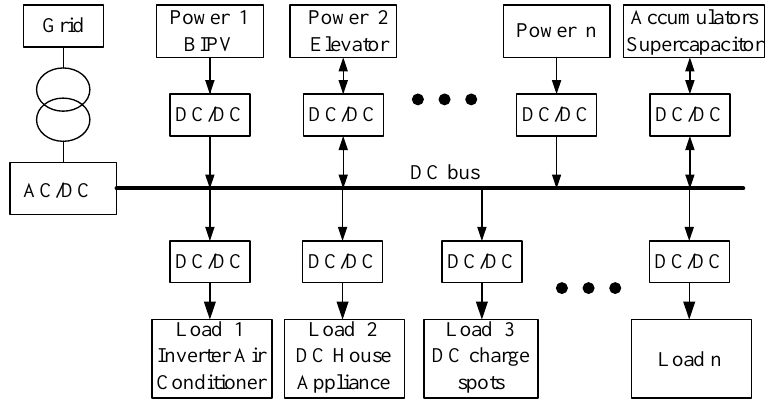
Figure 1. Architecture of building direct current (DC) distribution system.